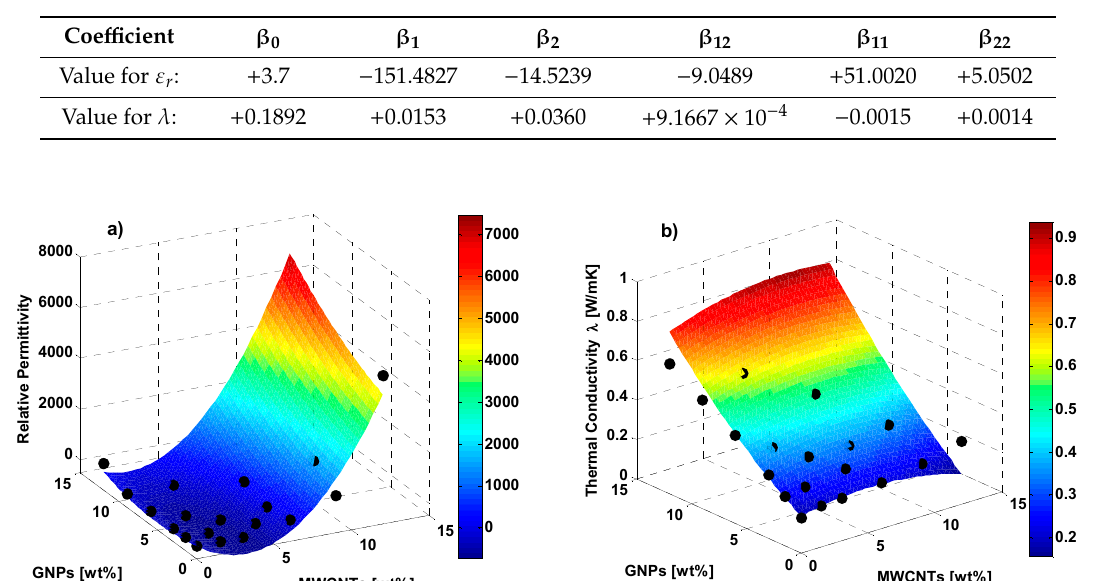
Table 3. RSM coe ffi cients for the quadratic response of the relative permittivity and the thermal conductivity experimental data.